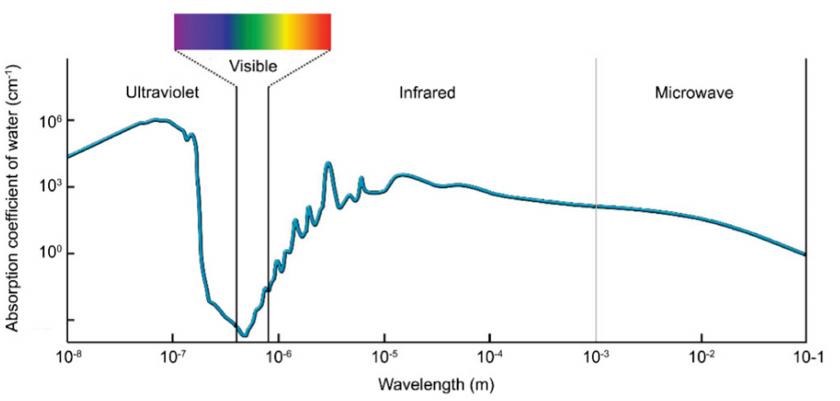
Figure 8. Absorption coefficient of pure seawater for different transmission wavelengths